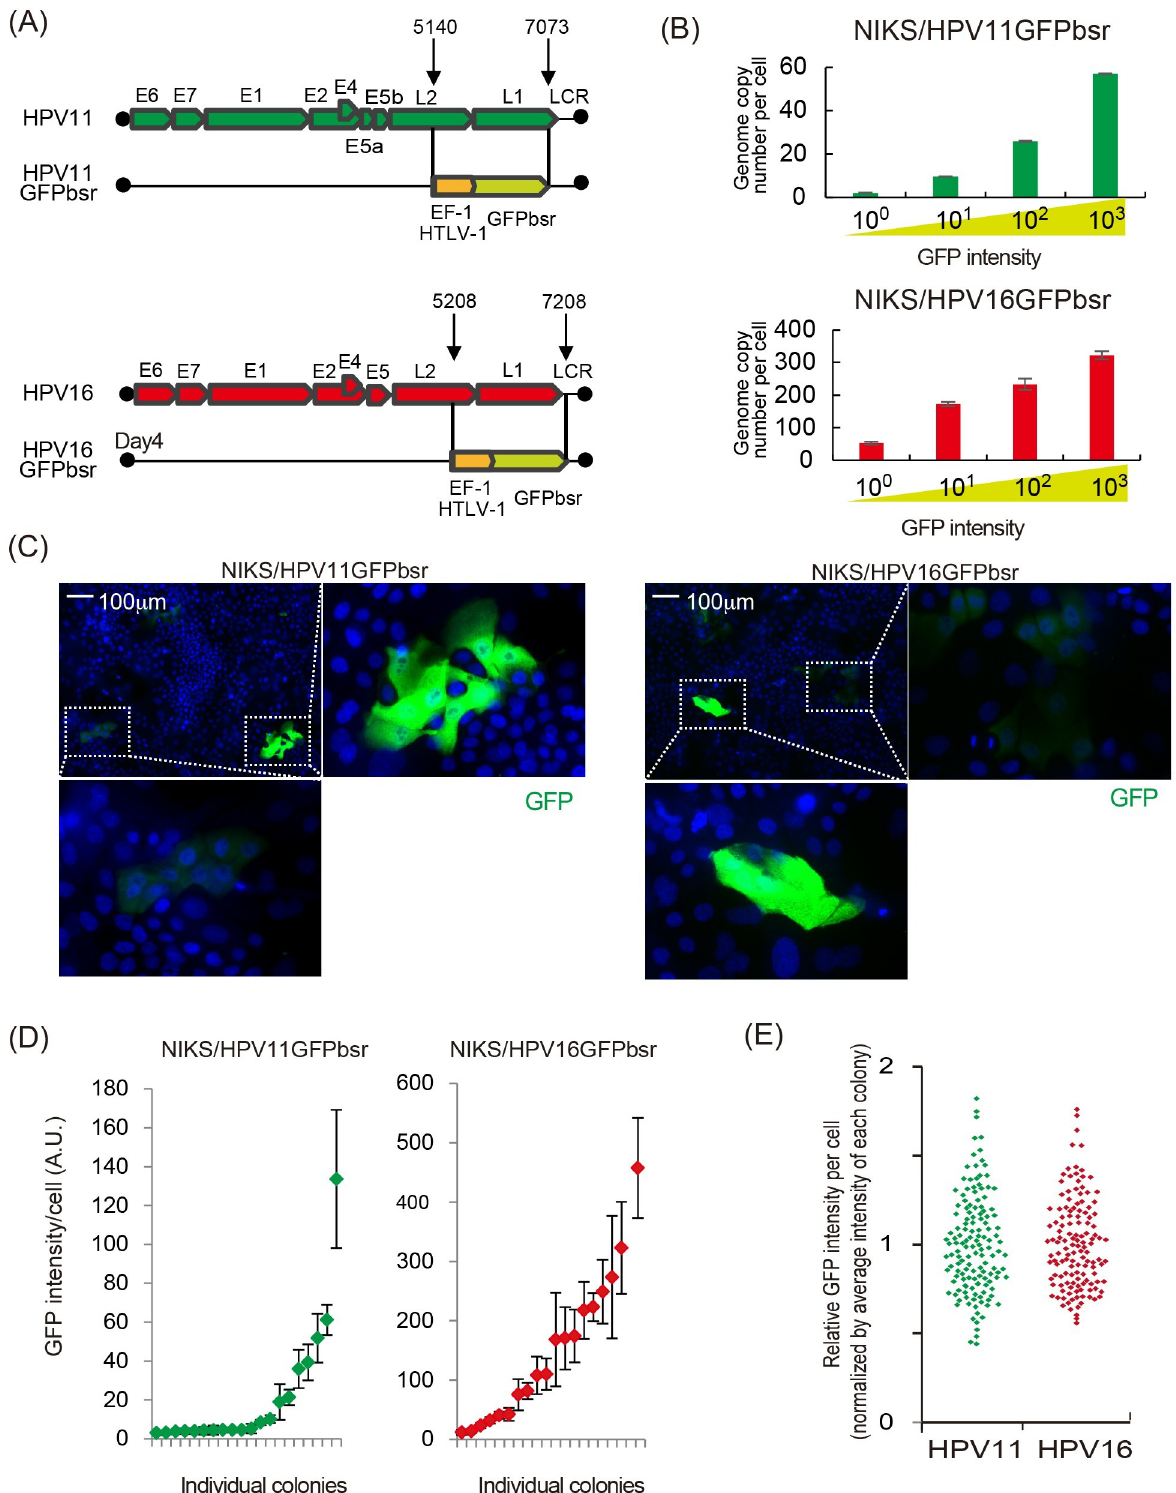
Fig 2. HPV11 and HPV16 are partitioned similarly in dividing NIKS cells. (A) The position of the hEF1-HTLV promoter-driven GFP-Blastocidin gene is shown in the context of the HPV11 and HPV16 genomes. The region between nt 5140 and 7073 is substituted by the GFPbsr cassette in HPV11GFPbsr, with a similar substitution between 5208 and 7208 in HPV16GFPbsr. (B) NIKS/HPV11GFPbsr or NIKS/